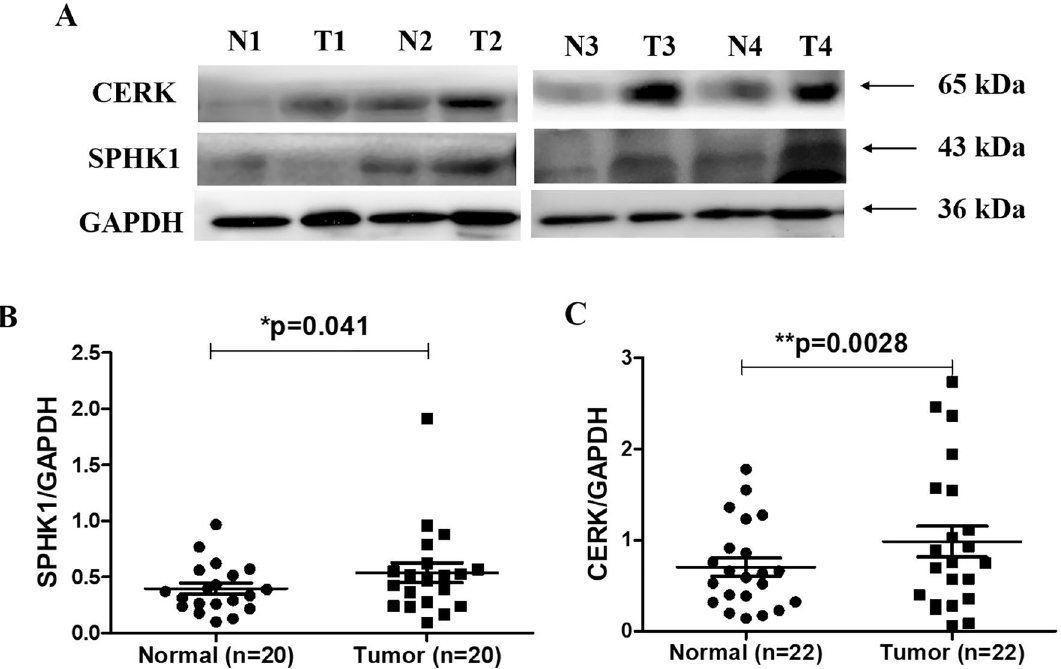
Figure 4. Protein expression of SPHK1 and CERK in breast cancer patients. ( A ) Representative blots in adjacent normal (N) and tumor (T) tissues, ( B ) Densitometric analysis of SPHK1 and ( C ) CERK levels in adjacent normal and tumor